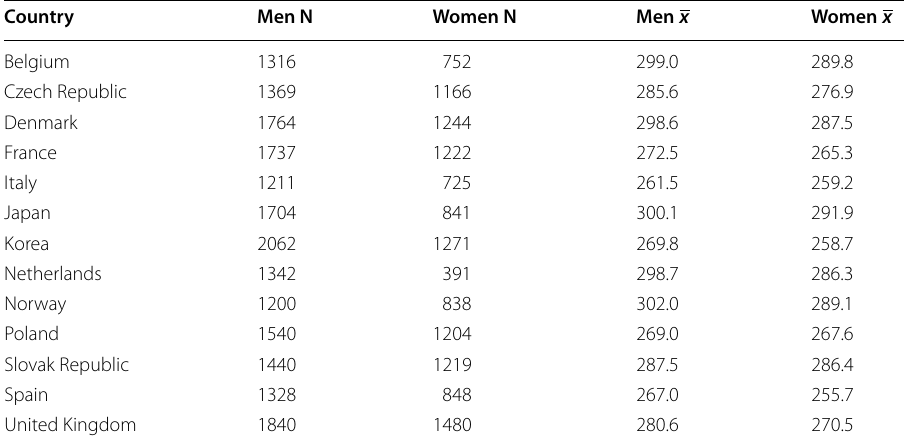
Table 1 Number of men and women in each country sample, with associated mean numeracy scores x . Source: PIAAC